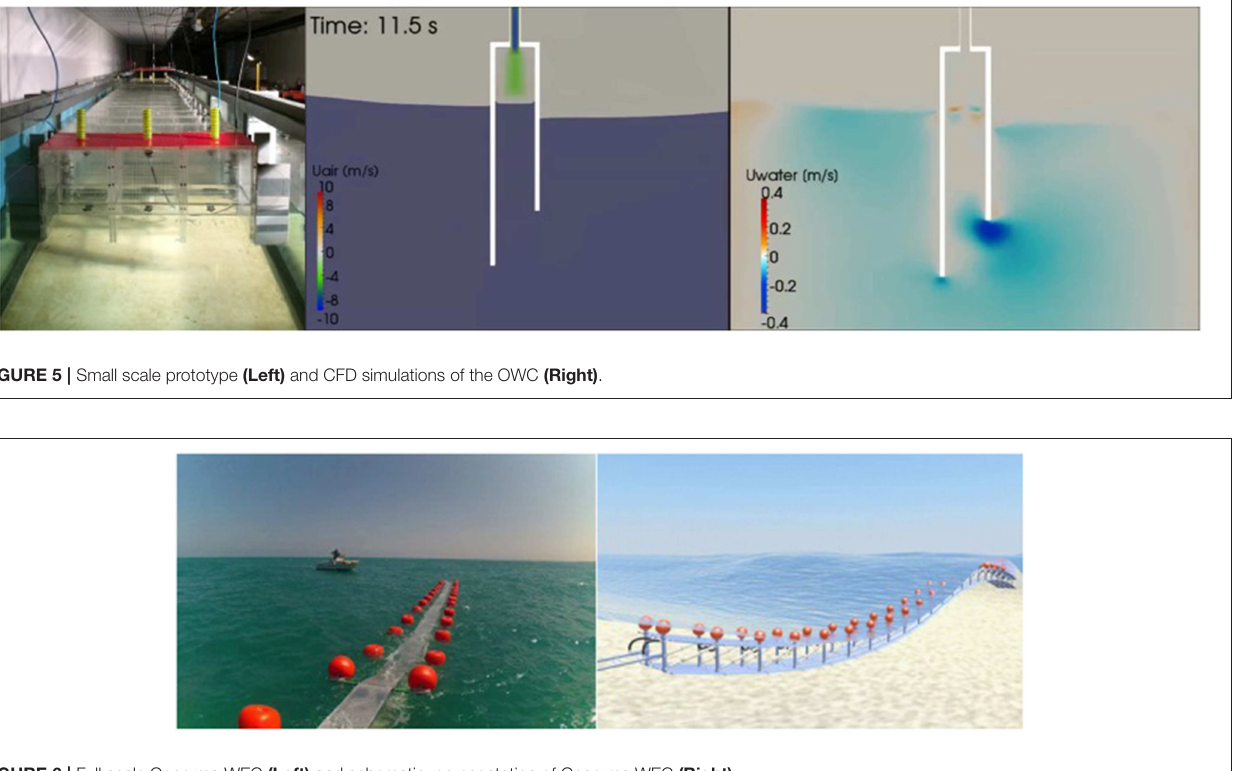
FIGURE 6 | Full scale Generma WEC (Left) and schematic representation of Generma WEC (Right) .